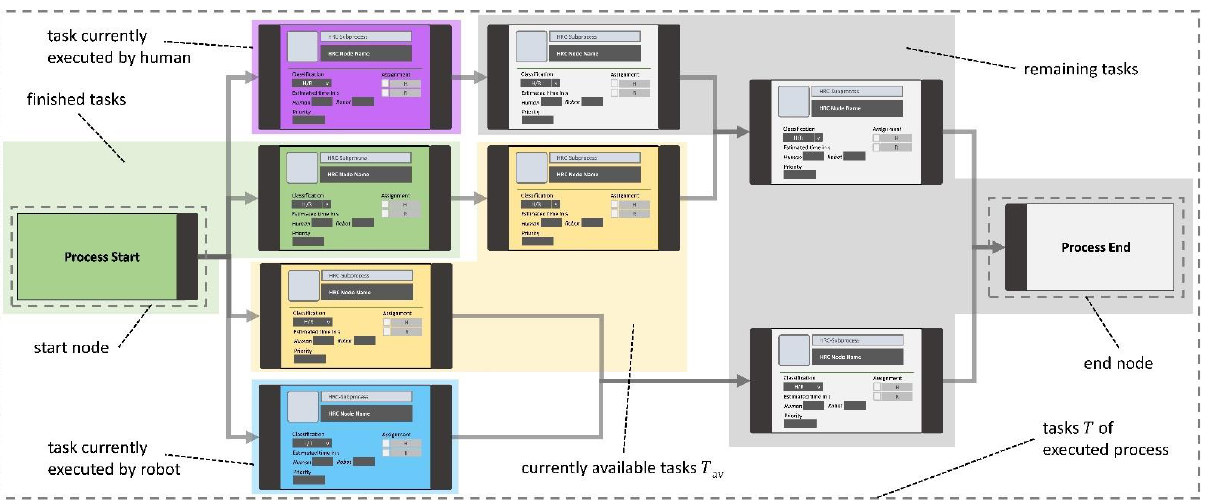
Figure 5. Conceptual representation of function blocks, which include sub-processes for the execution of the tasks by humans or robots (HRC nodes).